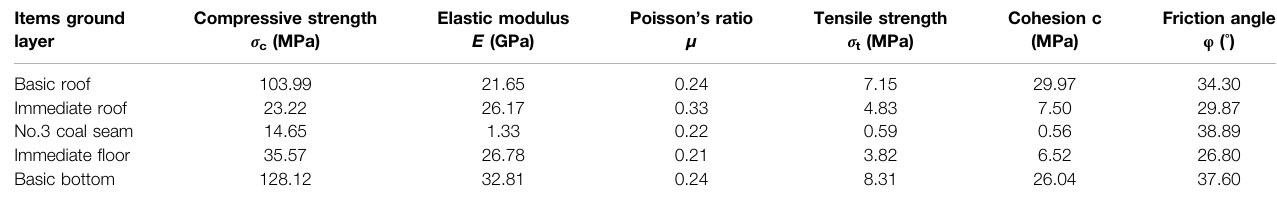
TABLE 1 | Mechanical parameters of coal seam and roof and fl oor strata in 1,303 working face. Items ground